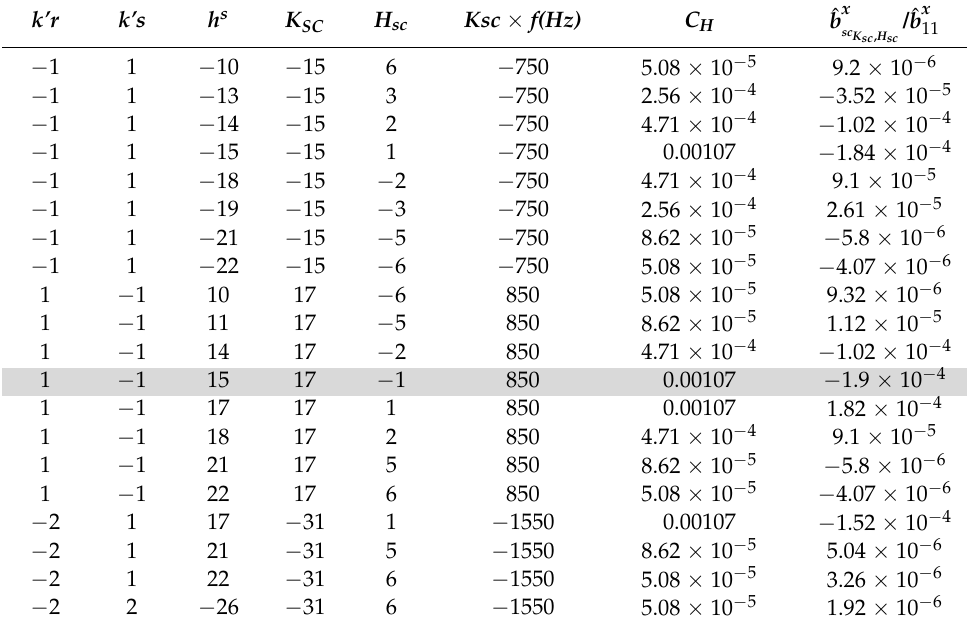
Table 2. Components generated by the faulty induction